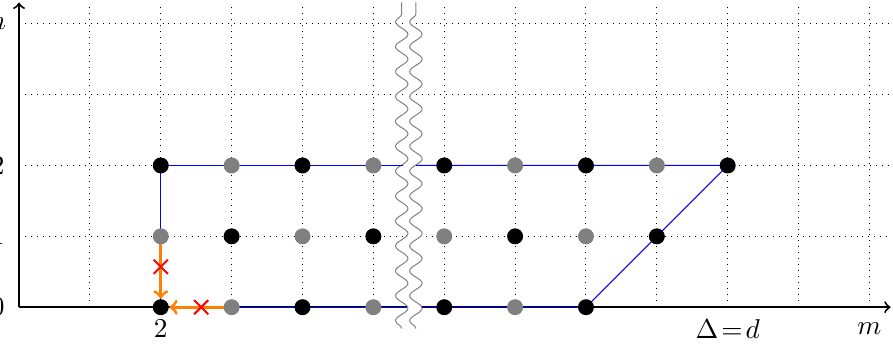
Figure 4. Decoupling of C [ d ](2 , 0) .